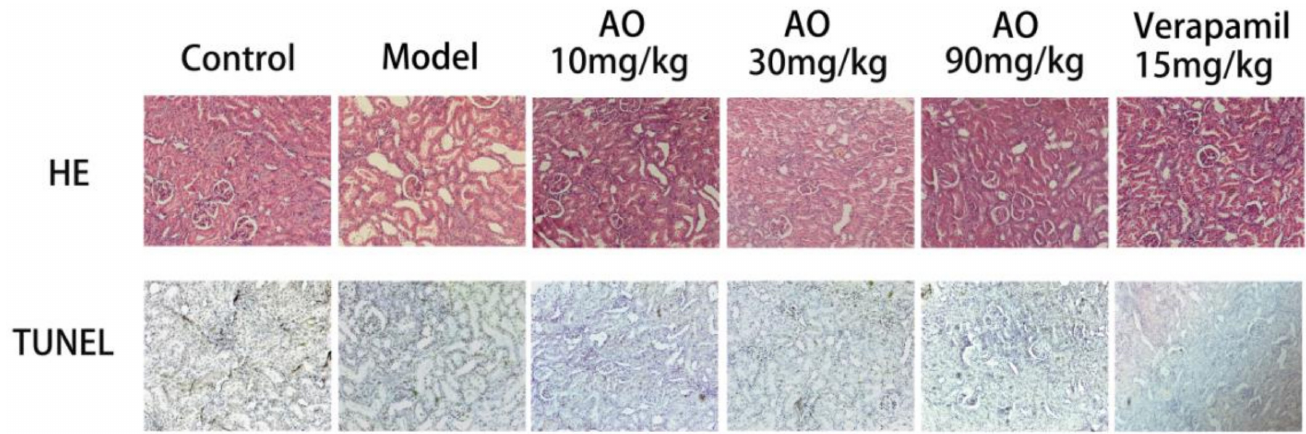
Figure 2. Effect of AO on histopathological changes of kidneys in GM-treated rats. Representative mi- crographs of each experimental group stained with hematoxylin and eosin and TUNEL, magnification ×